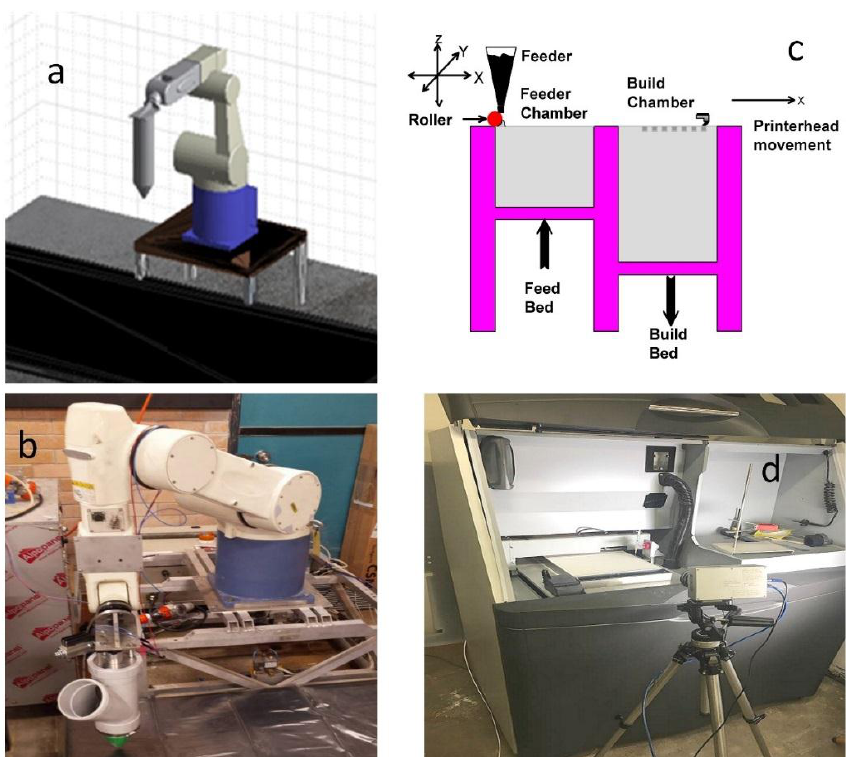
Figure 1. ( a ) Robot simulation, with the nozzle assembly attached, used to demonstrate the motion plans and check for potential collisions or undesirable paths; ( b ) a real-world robot with attached auger nozzle assembly; ( c ) schematic demonstration of the inkjet 3DP process; ( d ) real inkjet 3DP.